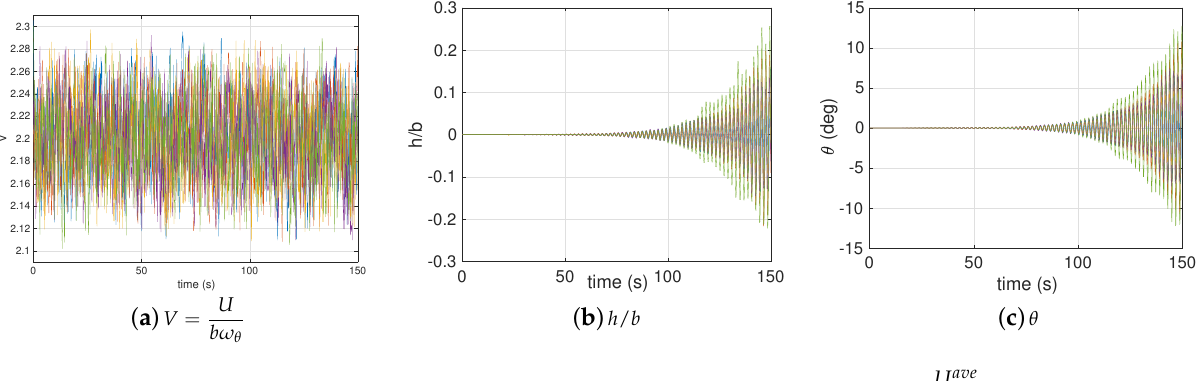
U ave = 2.2, and ∆ = b ω θ